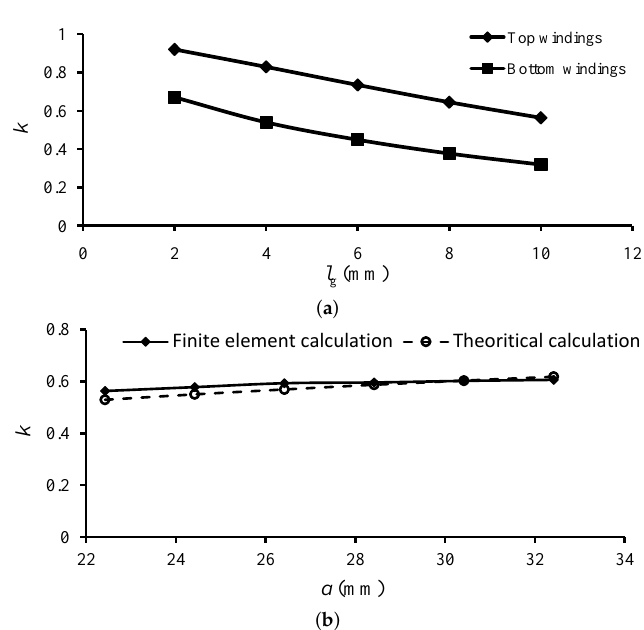
Figure 5. Relation to coupler parameters and coupling coefficient. ( a ) The relation between coupling coefficient and gap length; ( b ) Coupling coefficient versus effective radius of the magnet core.